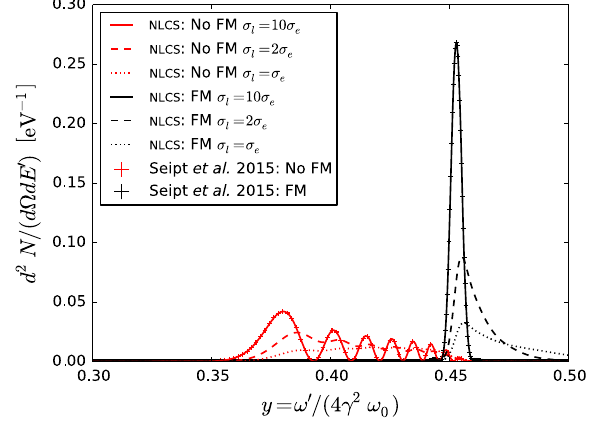
FIG. 1. Radiation spectra computed with our NLCS new code as the relative size of the laser waist ( σ l ) compared to the electron beam waist ( σ e ) is varied: significantly larger than ( σ l ¼ 10 σ e ; solid lines); somewhat larger than ( σ l ¼ 2 σ e ; dashed lines); and equal to ( σ l ¼ σ e ; dotted lines) the electron beam waist. Un- compensated spectrum (no FM) shown in red lines and optimally compensated (FM) shown in black lines. The red and black crosses come from the top panel of Fig. 2 in Ref. [21]. Spectra shown are for a linearly polarized 800-nm laser with a pulse duration of 21 fs and a 0 ¼ 1 on a Gaussian-distributed electron beam with a mean energy of 51